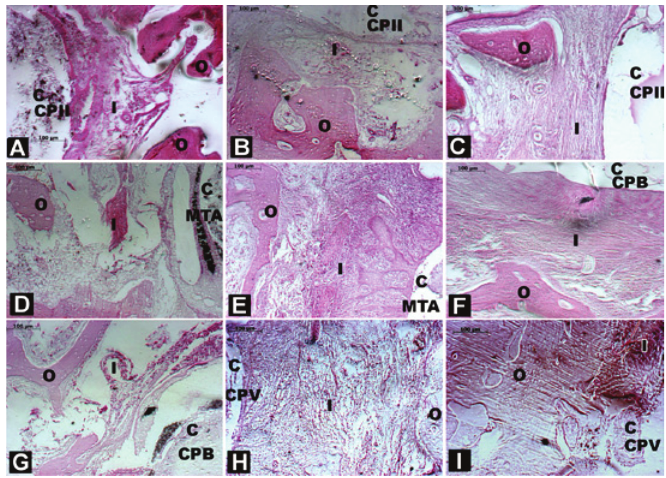
FIGURE 4 – Micrographs of furcation perforations treated with the different cements showing the inflammatory infiltrate ( I ) and newly formed bone ( O ). ( A , B , C ) Furcation perforations treated with Type II Portland cement ( CPII ). ( D , E ) Furcation perforations treated with MTA. ( F , G ) Furcation perforations treated with white Portland cement ( CPB ). ( H , I ) Furcation perforations treated with Type V Portland cement ( CPV